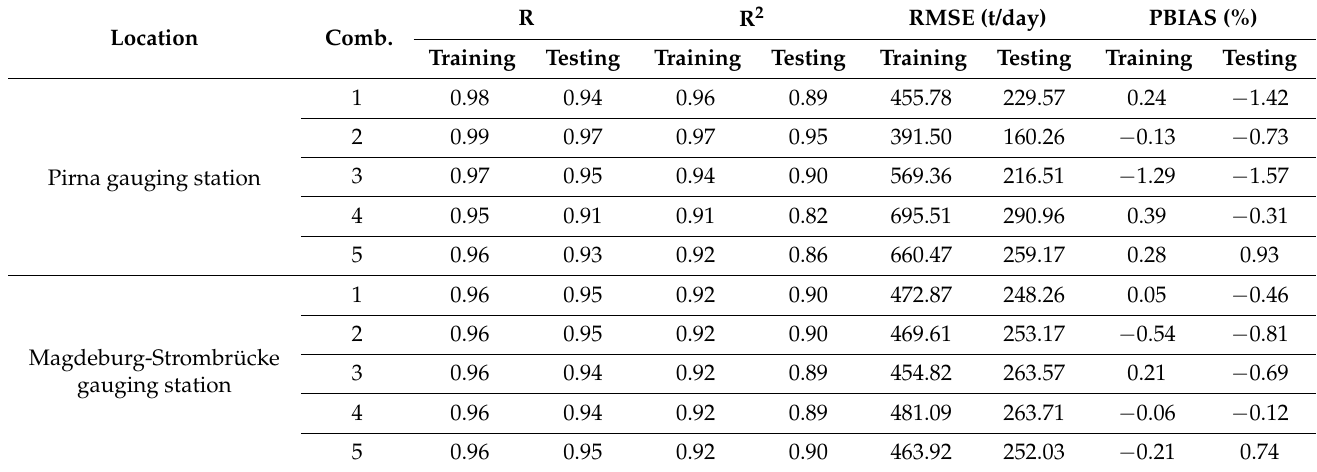
Table 8. The performance evaluation of the different WANN